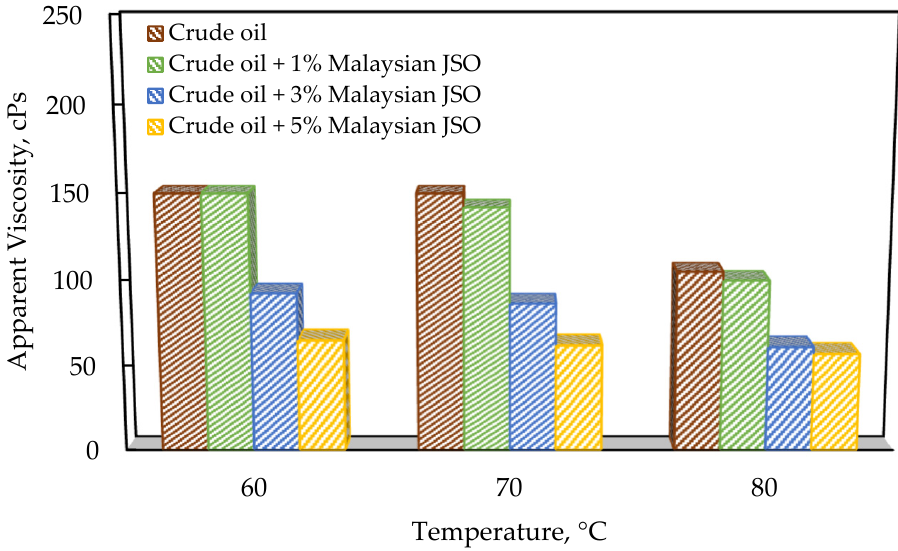
Figure 12. Rheological test of Panera waxy crude oil with and without addition of Malaysian Jatropha seed oil.